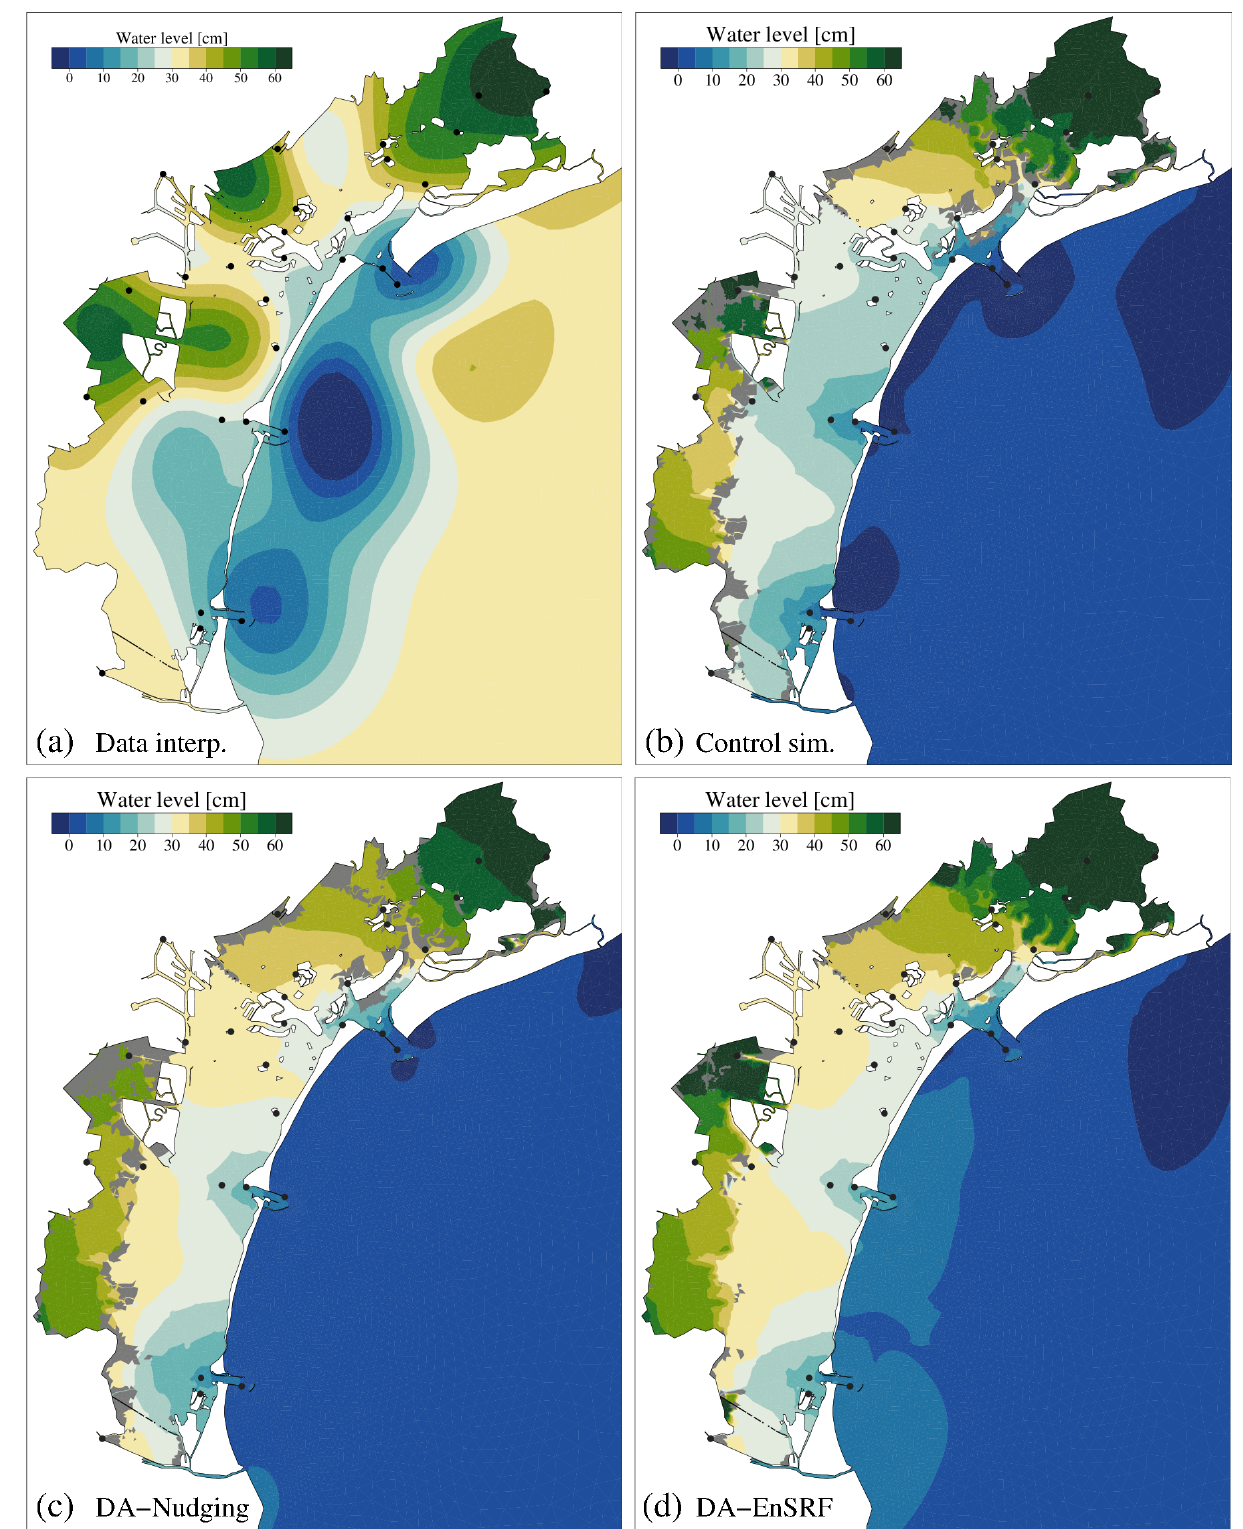
Figure 3. A snapshot on 4 November 2013 at 14:00UTC of the water level distribution in the Lagoon of Venice as obtained by the optimal interpolation (a) , the control simulation without assimilation (b) , the DA-nudging base run (c) , and the DA-EnSRF base run (d) . The grey colour indicates dry salt